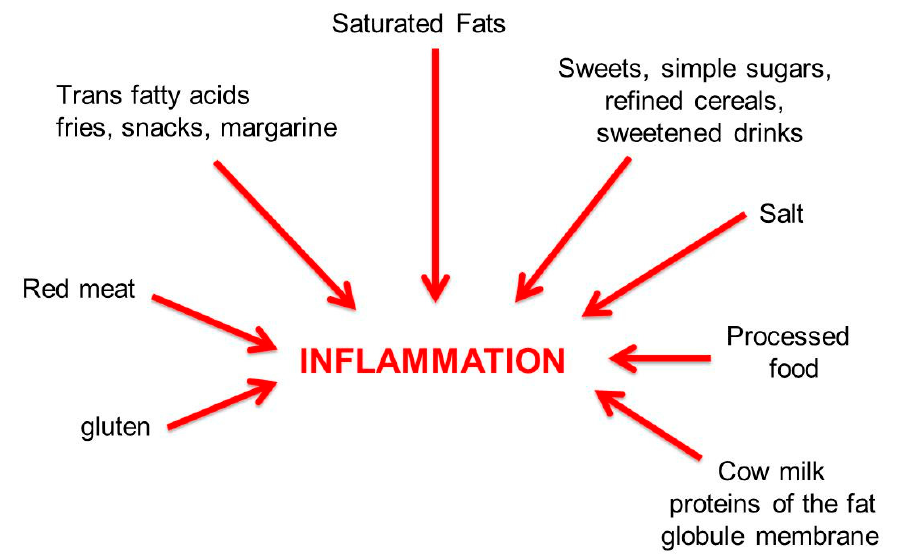
Figure 3. Pro-inflammatory dietary factors.